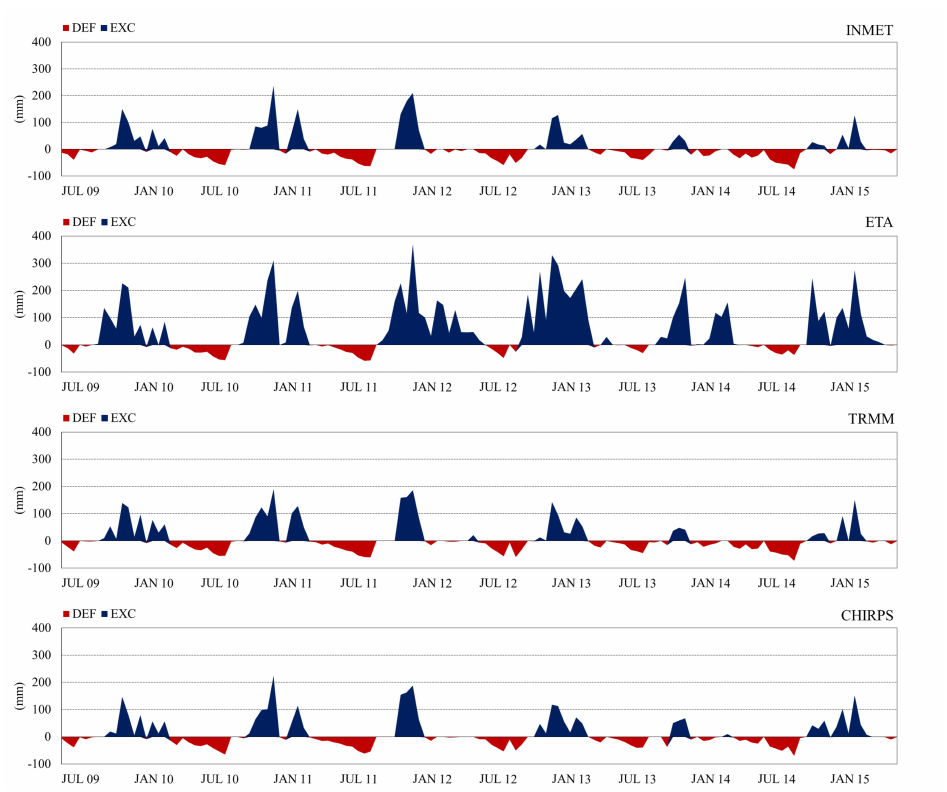
Figure 6. Average values of water deficit (DEF) and water surplus (EXC) estimated through the sequential water balance, with use of the observed data of INMET meteorological stations and the Eta, TRMM, and CHIRPS data for the period July 2009 to June 2015. Average values of evapotranspiration, determined with the INMET, Eta, TRMM, and CHIRPS data, are shown in Figure 7. The higher values of real ET are observed during the rainy seasons, with a reduction during the transition from the rainy to the dry season. Generally, ETR ETA values are higher than the ETR INMET values, while ETR TRMM and ETR CHIRPS values present a pattern similar to the ETR INMET values.